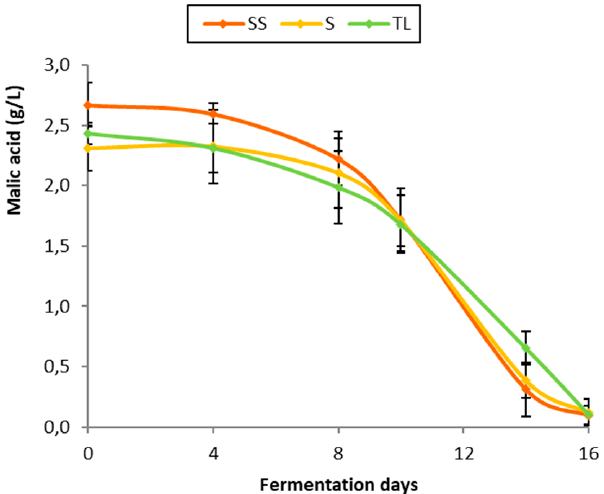
Figure 8. Evolution of malic acid concentration during MLF in the different inoculation strategies (SS: spontaneous sulfite, S: spontaneous without SO 2 , TL: inoculation with T. delbrueckii / L. thermotolerans at vatting without SO 2 ).